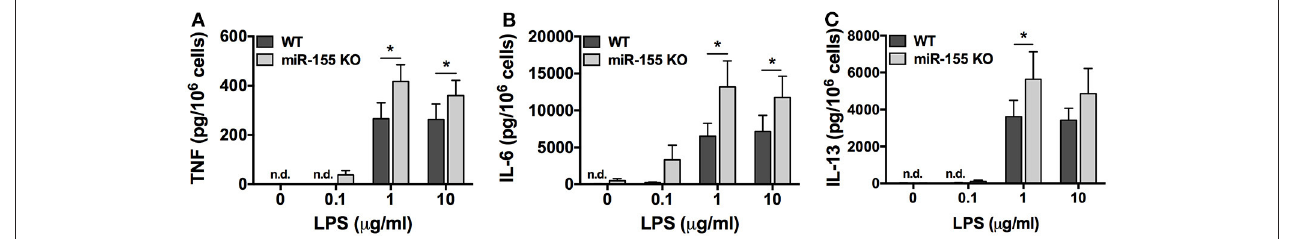
FIGURE 6 | TLR4-induced cytokine production is enhanced in miR-155 KO BMMCs. Wild-type and miR-155 KO BMMCs were treated with 0.1, 1, or 10 µ g/ml of LPS for 24h and secreted TNF (A) , IL-6 (B) , and IL-13 (C) were measured by commercial ELISA. The bar graphs represent mean ± SEM of values obtained from independent experiments with three different BMMC cultures from different mice. Cytokines in untreated samples were generally below the level of detection. Lowest level of detection for TNF, IL-6, and IL-13, respectively, were 31.2, 15.6, and 62.5 pg/ml. n.d., not detected. Significance was determined with Student’s t -test. * p < 0.05.